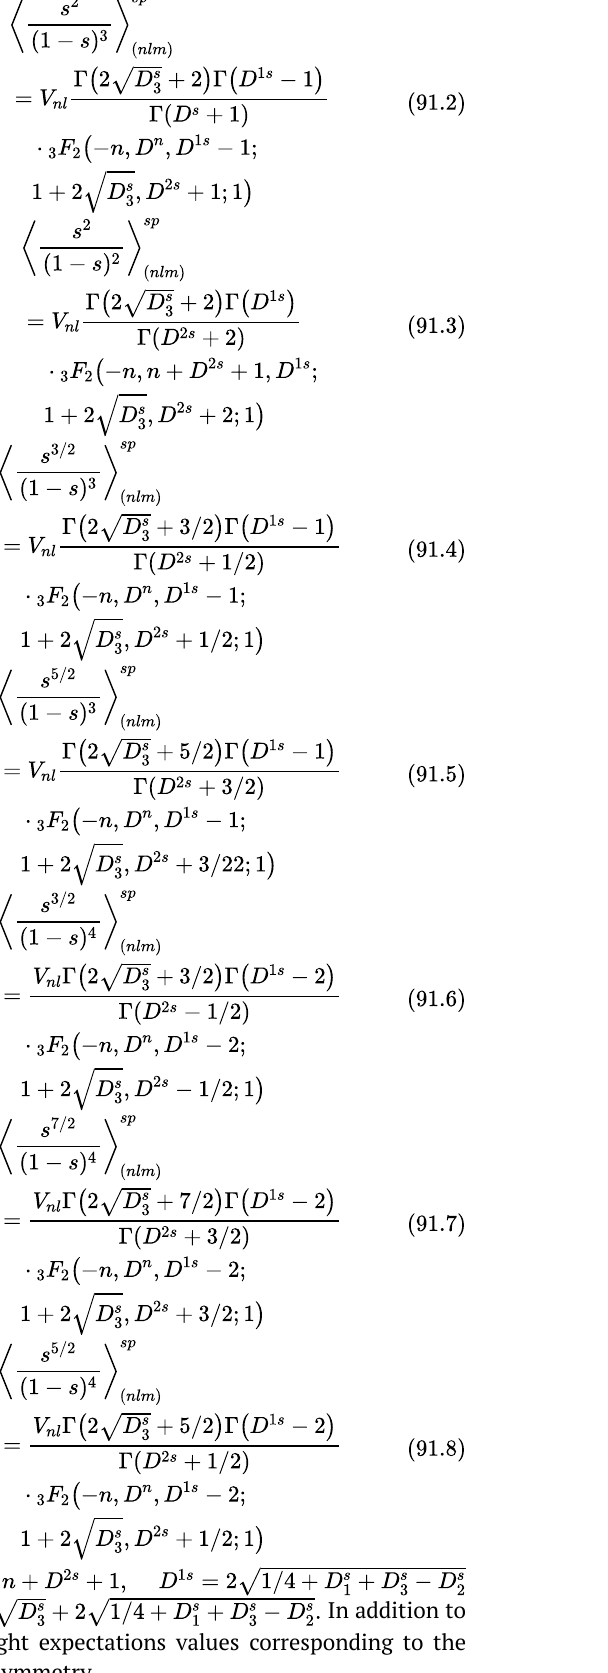
with and In addition to the other eight expectations values corresponding to the pseudospin